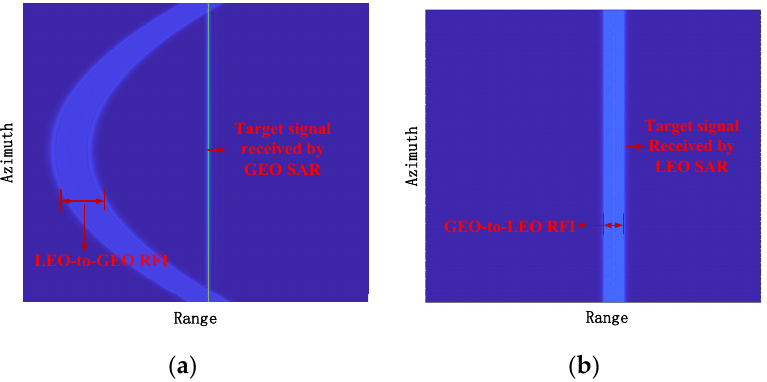
Figure 5. Range compression result. ( a ) the RFI which is transmitted by the LEO SAR, scattered by the scene center, and received by the GEO SAR and the target echo which is transmitted and received by the GEO SAR; ( b ) the RFI which is transmitted by the GEO SAR, scattered by the scene center, and received by the LEO SAR and the target echo which is transmitted and received by the LEO SAR. Table 4. Length and drift of the interference zone in range-direction for different points and inte- gration time.